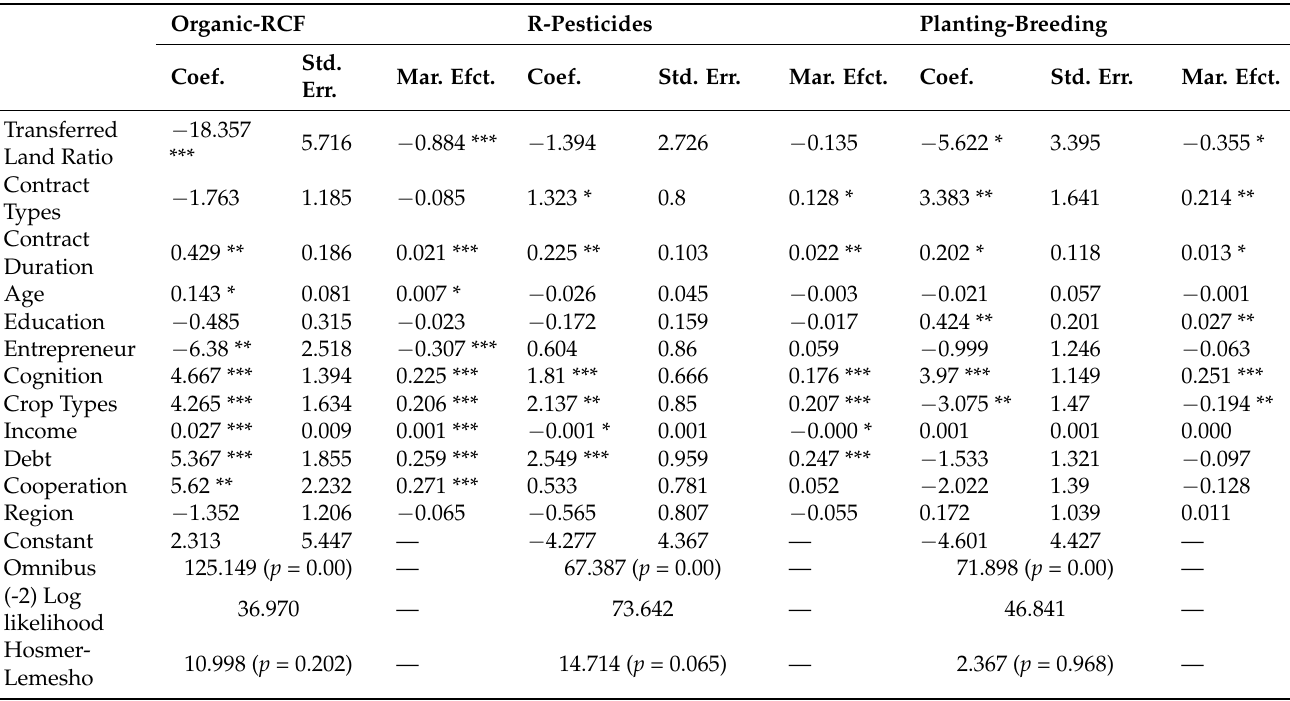
Table 5. Estimation results of family farms’